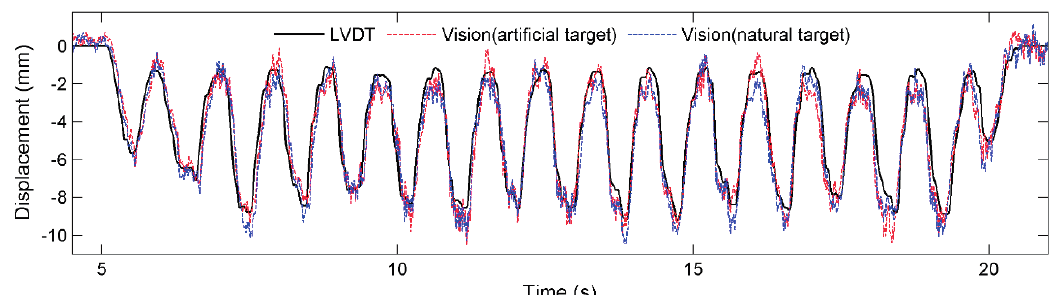
Figure 12. Comparison of displacements: Test T1.